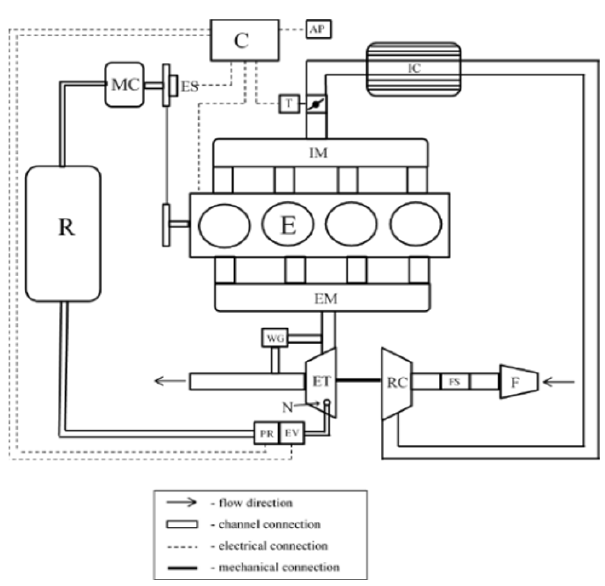
Fig. 1. Short-term compressed air supercharging system downstream of the turbocharger assembly: E – engine, EM – exhaust manifold, WG – west gate, ET – exhaust turbine, PR – pressure regulator, T – throttle, EC – electromagnetic clutch, F – air filter, RC – radial compressor, IC – inter- cooler, IM – intake manifold, C – controller, AP – accelerator/throttle pedal, R – reservoir, FS – mass airflow sensor, EV – valve, MC – mecha-